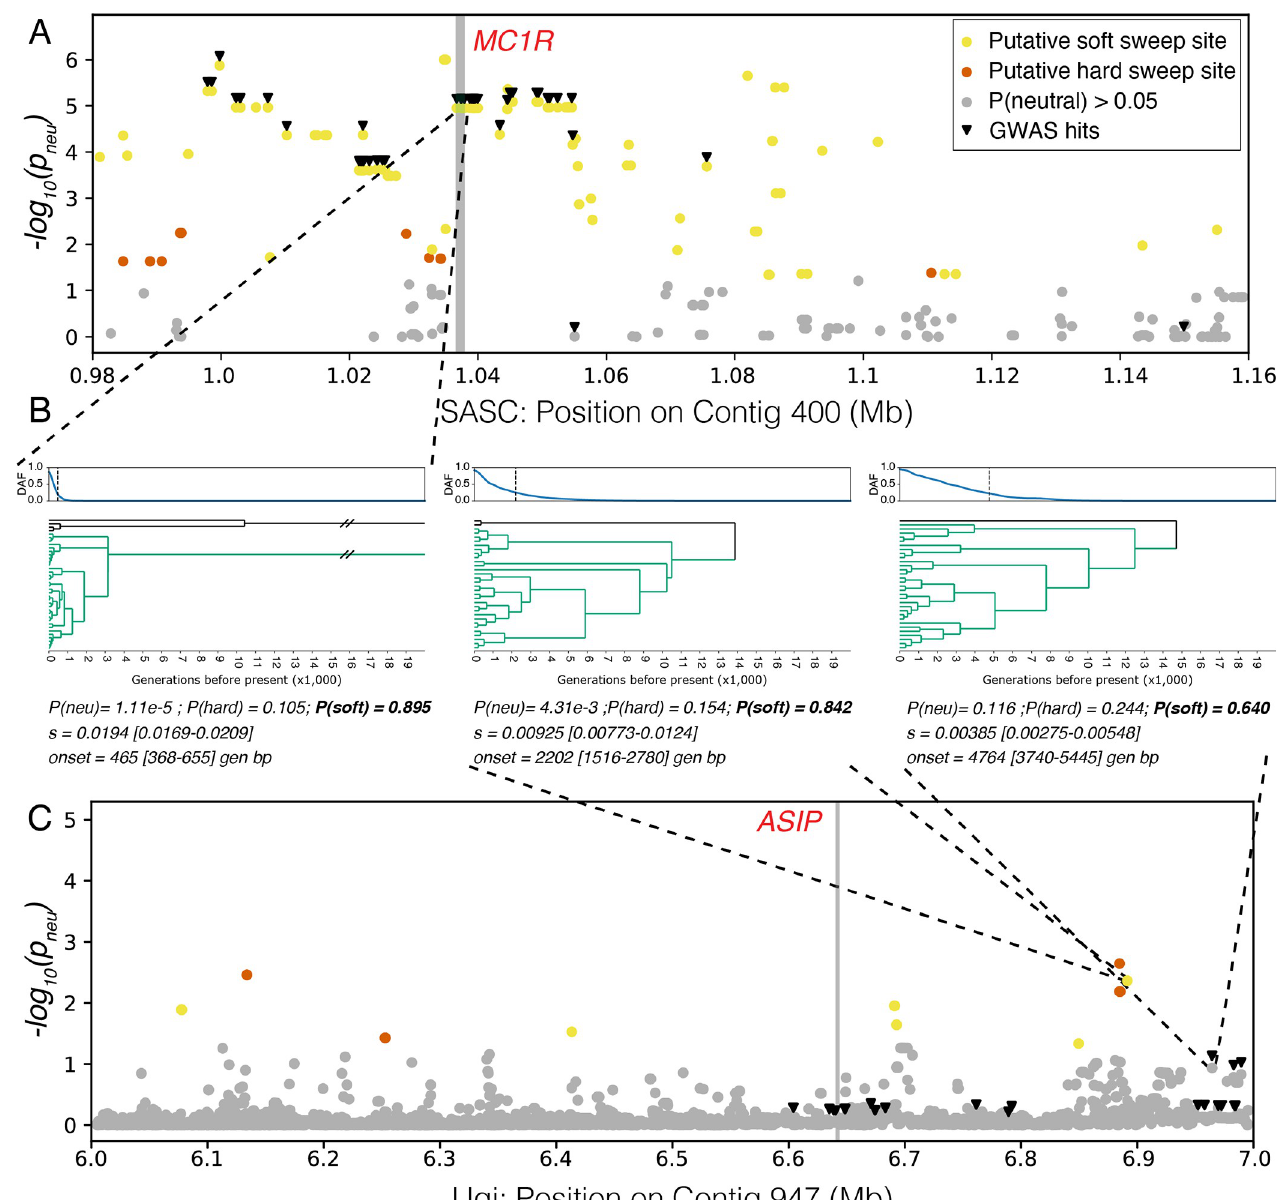
Fig 5. Estimation of positive selection at MC1R in the SA/SC population and at ASIP in the Ugi population using SIA. A . Negative log probability of neutrality ( -log(p neu ) ) in the SA/SC population at candidate sites near the MC1R gene. GWAS hits are highlighted with inverted triangles. Significantly non- neutral sites (p neu < 0.05) are colored by the predicted class with the highest probability. B . Inferred derived allele frequency (DAF) trajectories, local genealogies and selection parameters at three loci of interest. 95% confidence intervals of inferred selection parameters are shown in square brackets. These were estimated using random dropouts at inference time (see Materials and Methods ). The vertical dashed line on the DAF plot indicates selection onset inferred by SIA. Derived lineages are colored in aquamarine. Highlighted here are a GWAS locus in the MC1R coding sequence, the locus inferred to be under the strongest selection near the ASIP gene and a GWAS locus near the ASIP gene. The location of these loci is projected onto panels ( A ) and ( C ) by dashed gray lines. C . Negative log probability of neutrality in the Ugi population at candidate sites near the ASIP gene. Details of the figure are otherwise similar to panel ( A